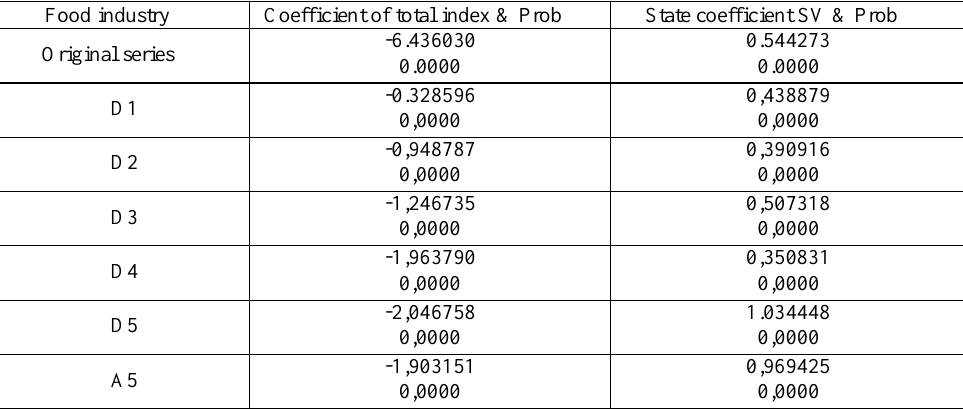
Table 1. Extracted coefficients from State-Space Model for food industry Food industry